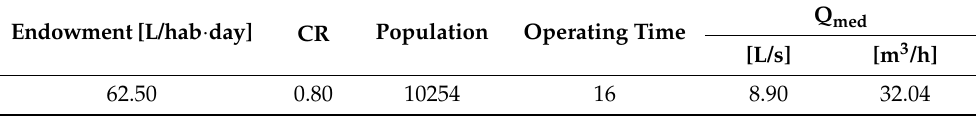
Table 15. CA1 input flow rate.